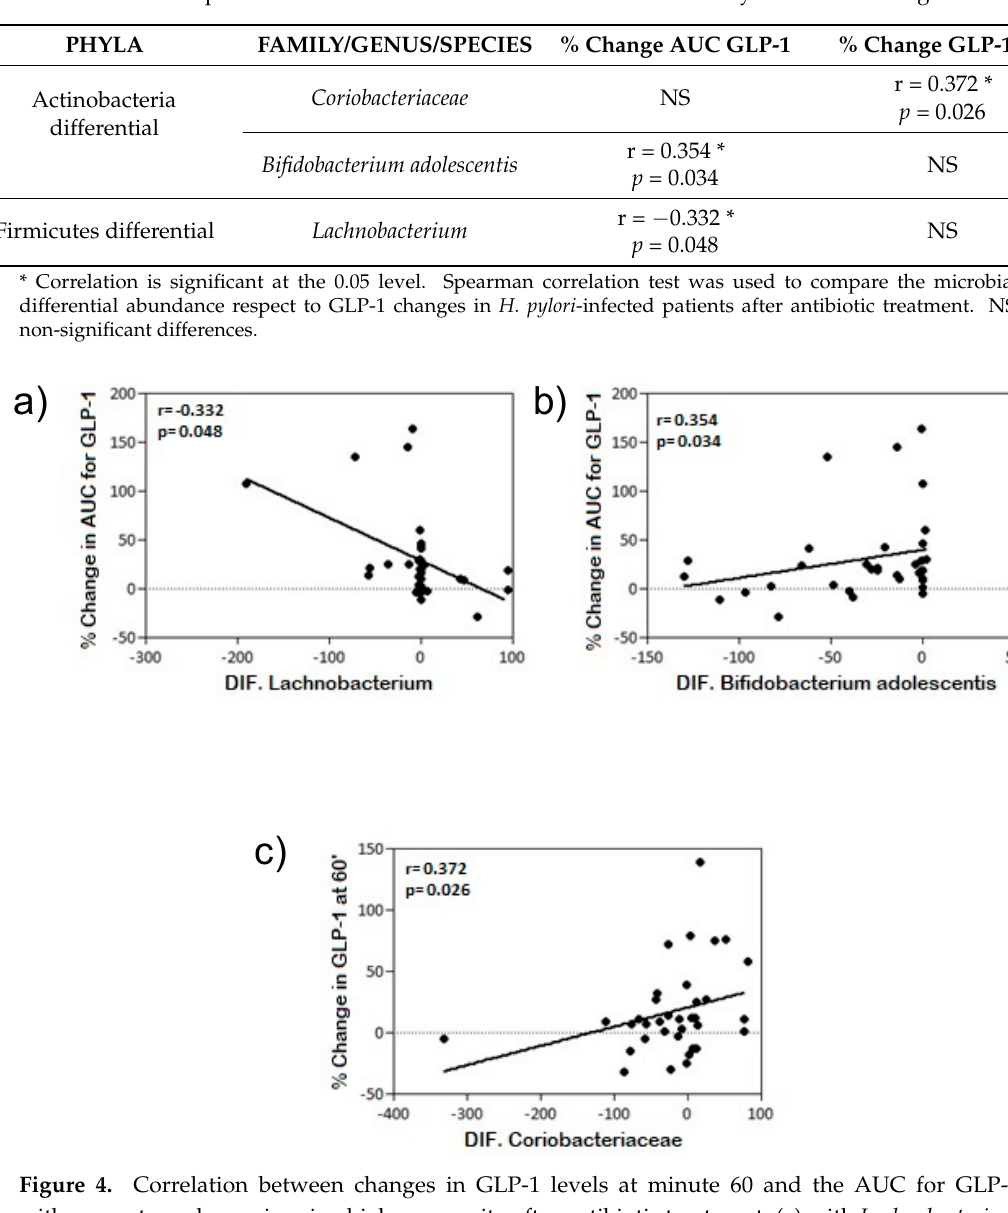
Table 2. Simple linear correlation: differential microbial community and GLP-1 changes.